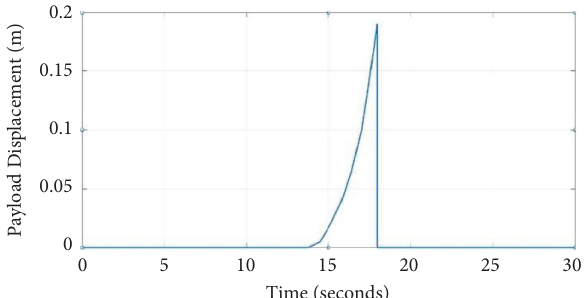
Figure 10: Te third input signal applied on the